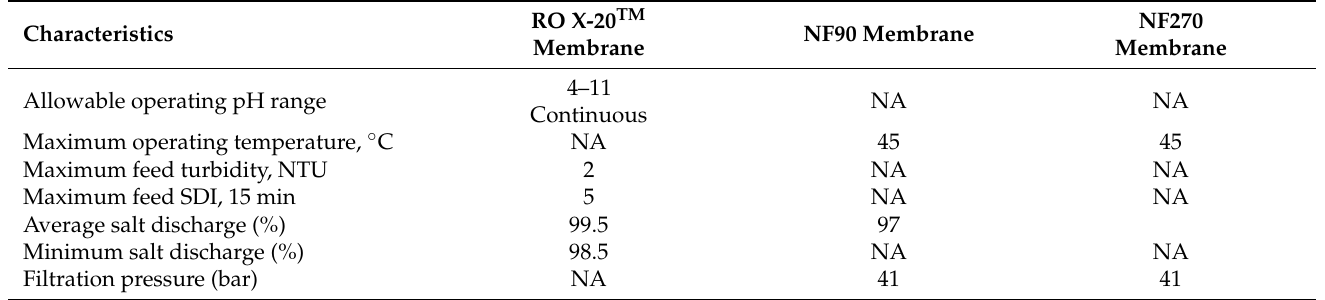
Table 3. Specifications of the membranes used in the experiments (information provided by the